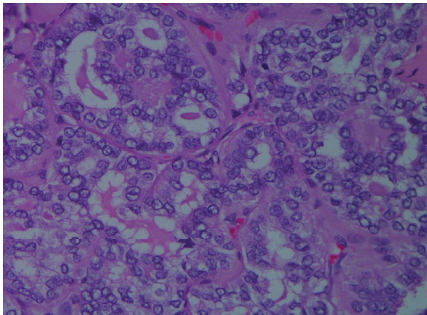
Figure 3: Microscopic examination showing infiltrative tumor with follicular architecture and eosinophilic scalloped colloid. There is overlapping and crowding of tumor cells with cytologic atypia. Numerous pseudoinclusions, nuclear grooves, and ground glass nuclei are also noted.